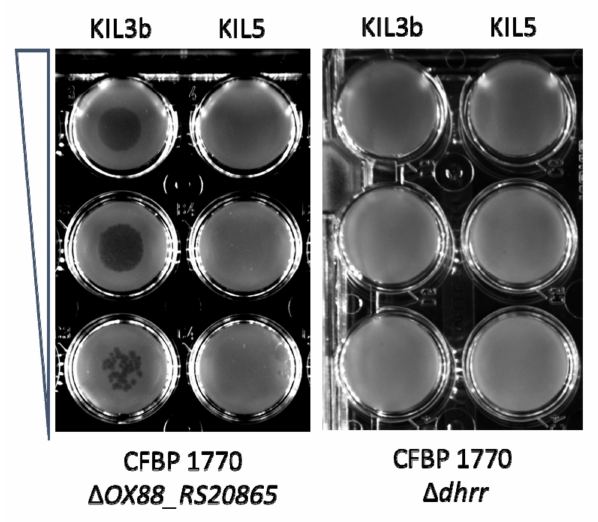
Figure A1. Spot assay showing the resistance and susceptibility of the transposon knock-out mutants to KIL3b and KIL5. On the left, CFBP 1770 ∆ OX88_RS20865 sensitive to KIL3b and resistant to KIL5, and on the right, CFBP 1770 ∆ dhrr resistant to both phages. A dilution series (10 6 – 10 5 – 10 4 PFU / mL)